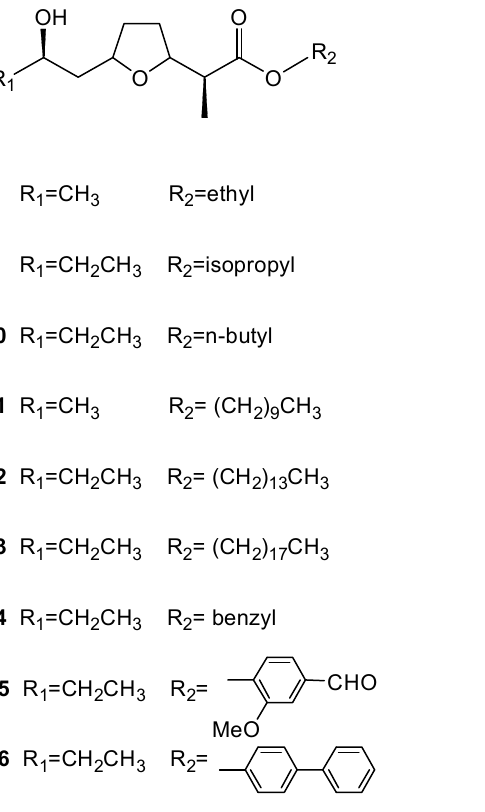
Figure 4. Structures of compounds 8 – 21 .